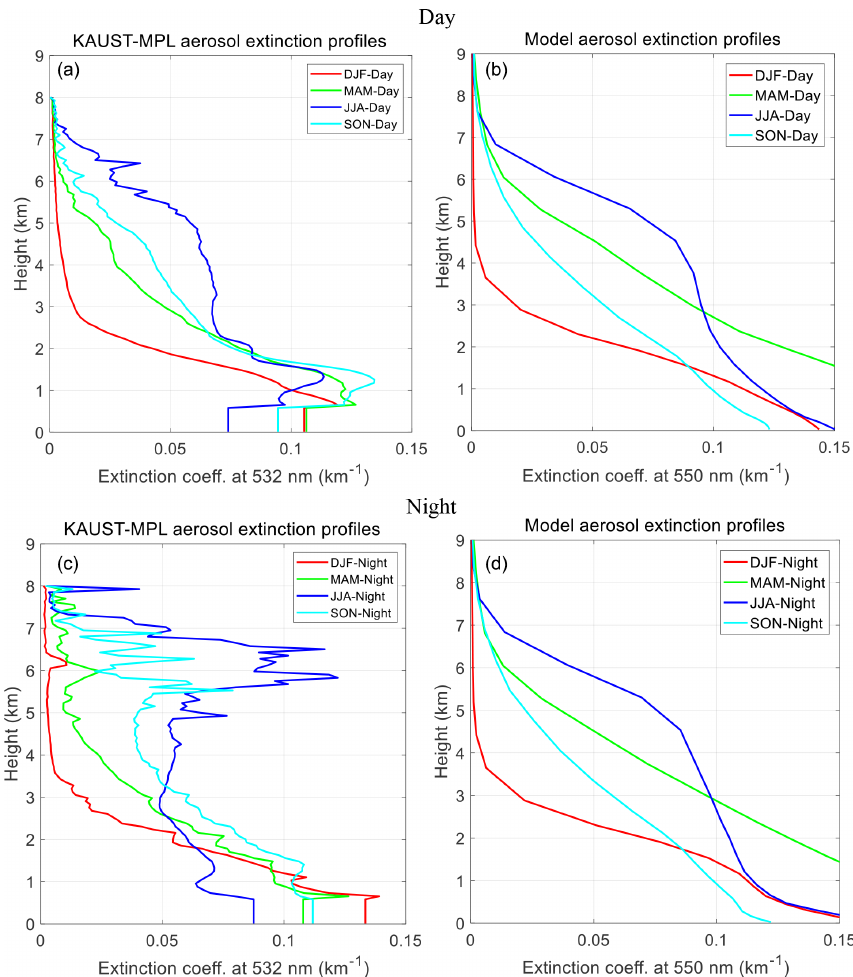
Figure 11. KAUST–MPL-retrieved (a, c) and model-simulated (b, d) aerosol extinction profiles for different seasons presented separately for the daytime (a, b) and nighttime (c, d) . The measurement times of all KAUST–MPL data available for daytime fall between 05:00 and 15:00UTC, and nighttime data fall between 17:00 and 02:00UTC. For the model, the daytime and nighttime data represent data between these